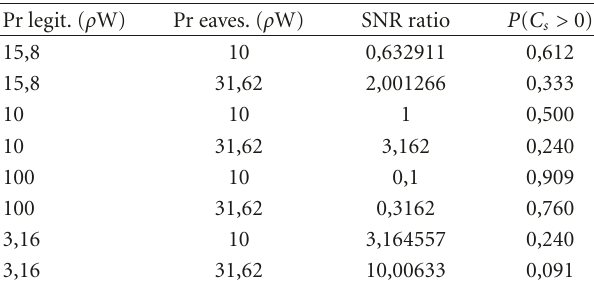
Table 6: P ( C s > 0) for NLOS (T5)